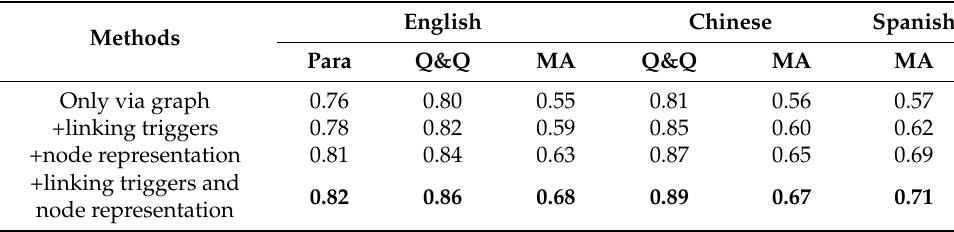
Table 5. The ablation results of our calculation (highest values in bold).